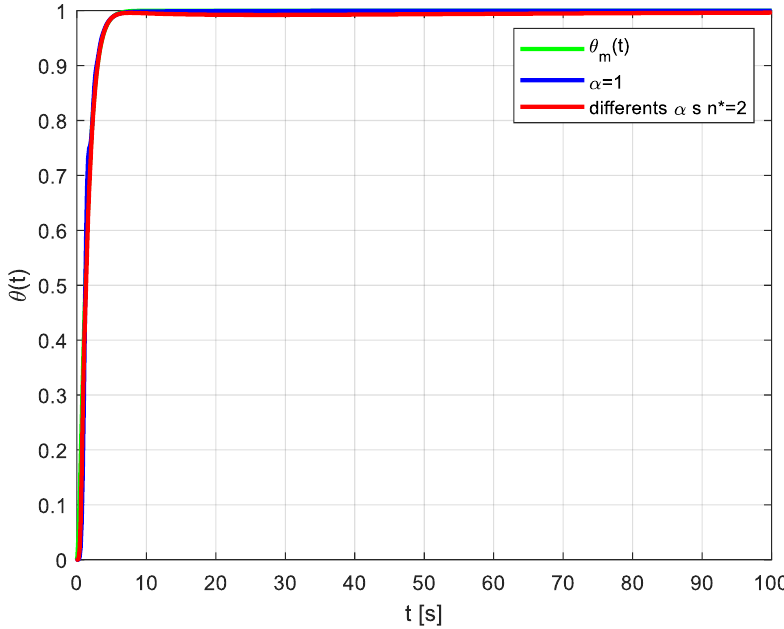
Figure 11. Pitch angle response 𝜃(𝑡) under IO-DMRAC and FO-DMRAC.